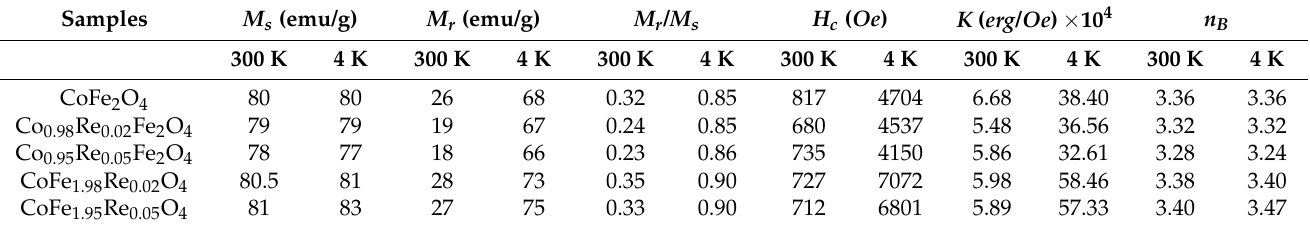
Table 2. Magnetic parameters ( M s , M r , M r / M s , H c , and K ) of Re-doped nanoparticles were extracted at 300 K and 4 K. With the increased Re doping ratio, the magnetic parameters reduced in Co-site doping, while they were enhanced in Fe-site